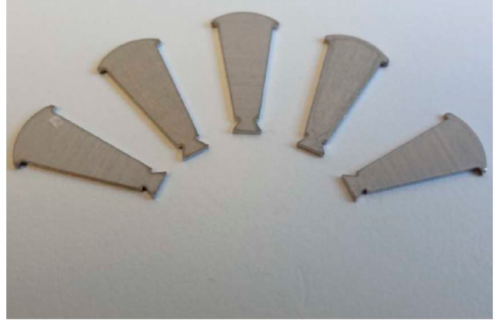
Figure 7. Rotor pole